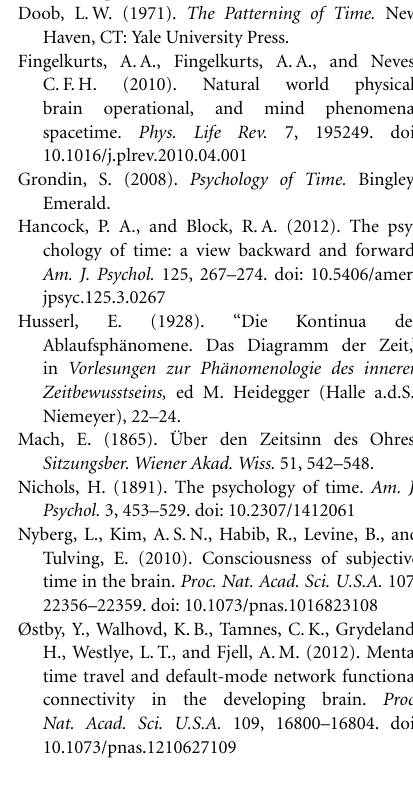
(biographic) as well as intra-episodic (actual experience), are cognitively projected (gray arrows) onto the dimension of physical world time (horizontal arrow) which serves as a common reference for all time-orders and time-scales. Note: The two-dimensional map P n → P (cid:3) n is essentially Husserl’s (1928) “diagram of time,” modified in order to illustrate the non-linear metric of subjective duration and the finite horizon of time experience (cf. Wackermann, 2005, p.